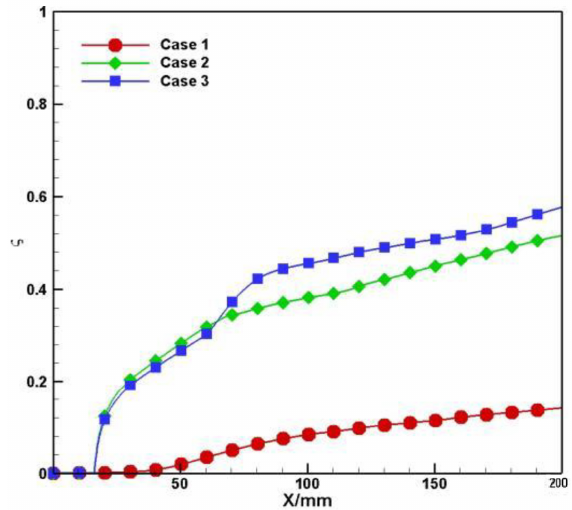
Figure 11. Pressure loss coefficient along streamwise direction for three